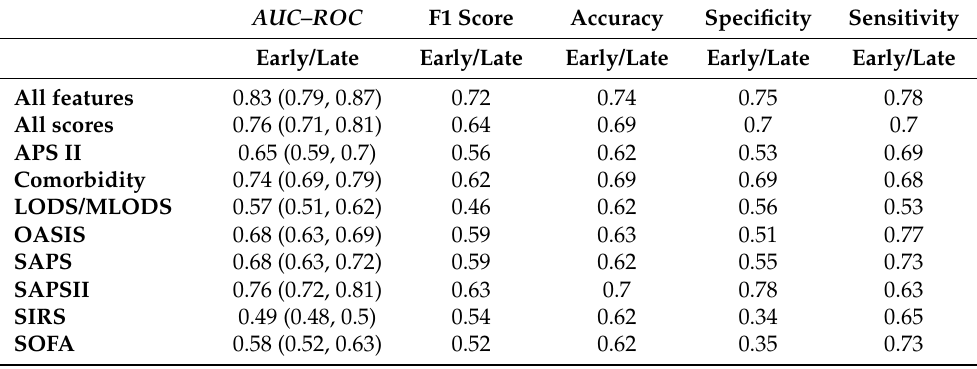
Table A4. Analytical metrics of performance of predictive models for late mortality in patients with thrombosis from the MIMIC-III database (Abbreviations: APS, Acute Physiology Score; LODS, Logistic Organ Dysfunction Score; OASIS, Outcome and Assessment Information Set; SAPS, Simplified Acute Physiology Score; SIRS, Systemic Inflammatory Response Syndrome; SOFA, Sequential Organ